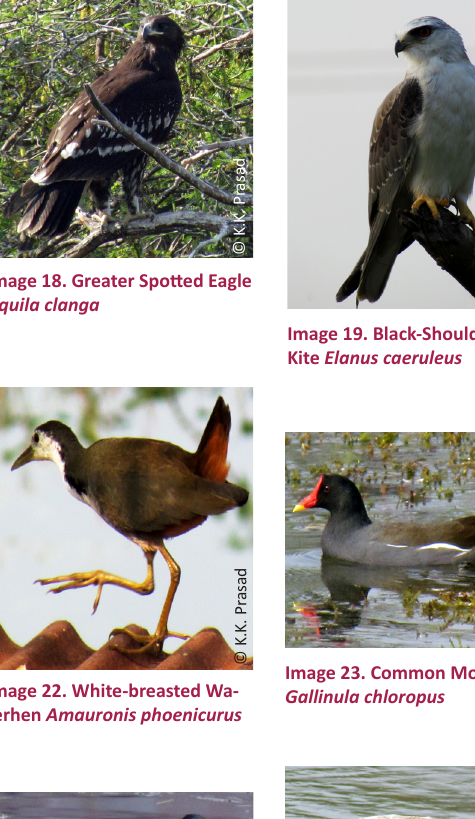
Image 28. Little Ringed Plover Charadrius dubius